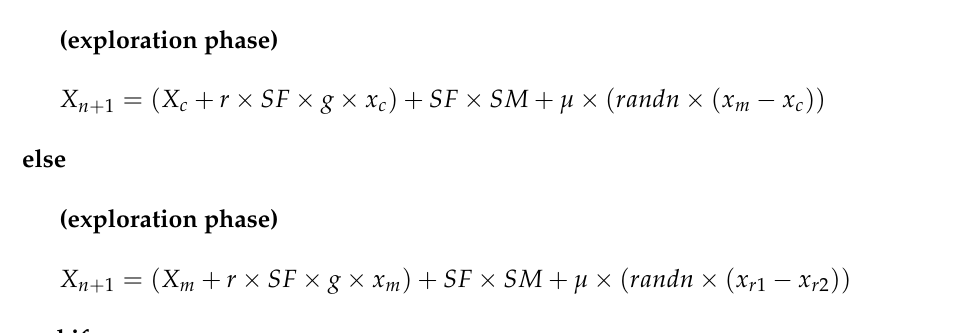
Algorithm 1 Search mechanism (SM) to update the position of current solution used in RUN if rand < 0.5